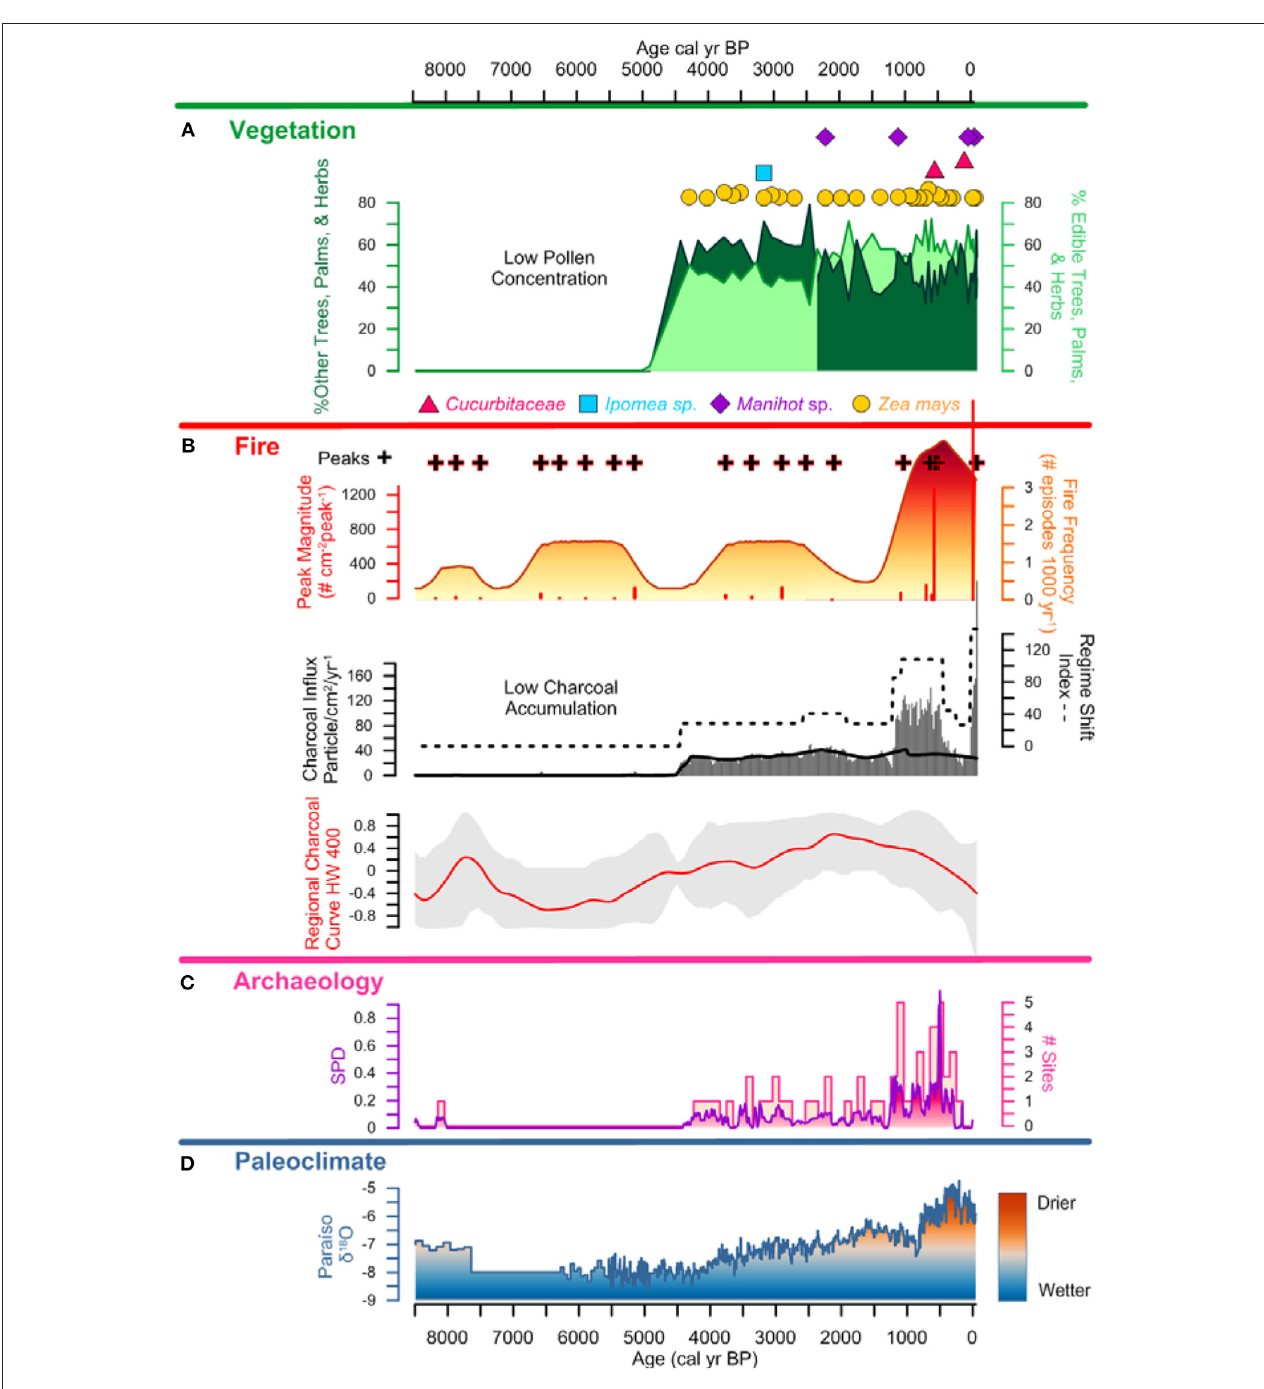
FIGURE 6 | Lago Caranã Summary Figure 8,500 cal yr BP to Present: (A) vegetation: pollen summary data of edible and other trees, palms, and herbs, and crop pollen including maize ( Z. mays ), sweet potato ( Ipomea sp.), manioc ( Manihot sp.), and squash ( Cucurbita ), (B) fire: charcoal influx with black line indicating background, RSI, fire frequency, peaks, and peak magnitude from CHAR Analysis, and regional charcoal curve from sites compiled from the GCD, (C) archeology: summary data calculated from the sum of calibrated probability distributions (SPDs) and site frequency data (Maezumi et al., 2018), (D) paleoclimate: data from Paraíso Cave (Wang et al.,